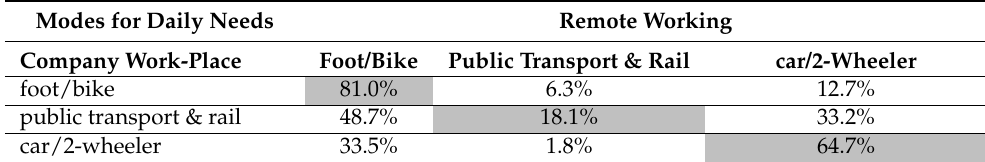
Table 4. Frequencies of the modes of travel for daily needs when working remotely and at office. Modes for Daily Needs